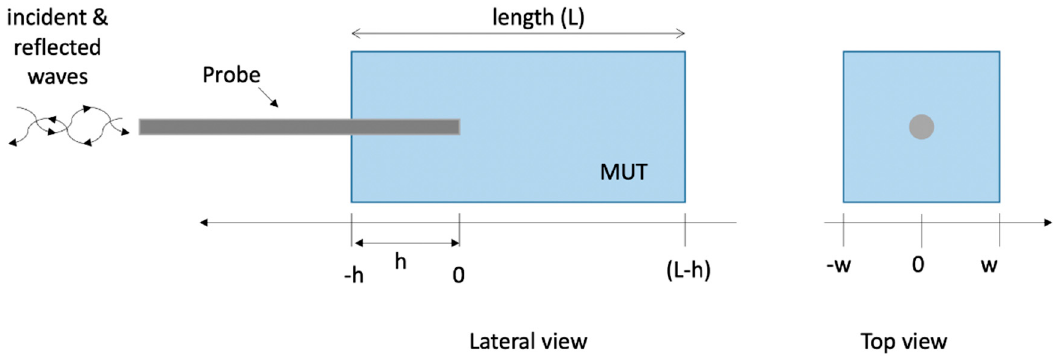
Figure 1. Geometry of the probe inserted into a parallelepiped of material (distilled water for calibration purposes, or liver and fat tissues).